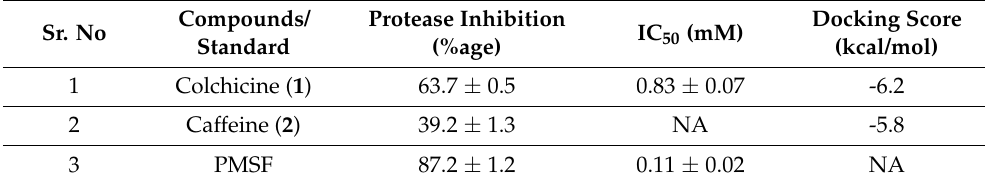
Table 5. Protease inhibition activity and molecular docking studies of the purified compounds. Sr. No